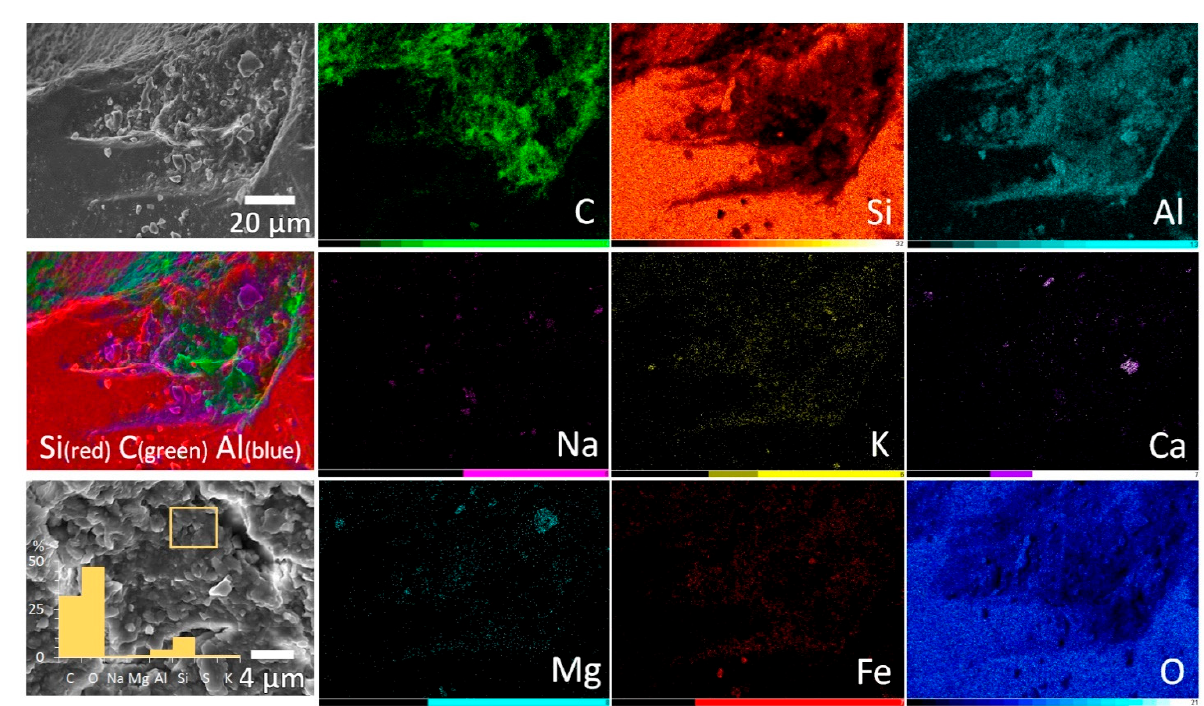
Figure 3. SEM micrographs and maps of elements occurrences obtained from energy-dispersive X-ray spectroscopy in a micron-scale cavity on quartz grain filled with clays in association with carbonaceous substances including bacteria (AB horizon from the BB 63–58 soil profile). The first left column from top to bottom: general view on the region of interest in secondary electrons; composite image indicating the close occurrence of carbon and clay particles (Al as a proxy) in microdepression on quartz (Si as a proxy); close view on organo-mineral film indicating the intimate interplay of clays, bacteria and EPS. All other columns—Maps of individual elements occurrences; the scale is the same as for the overview image.